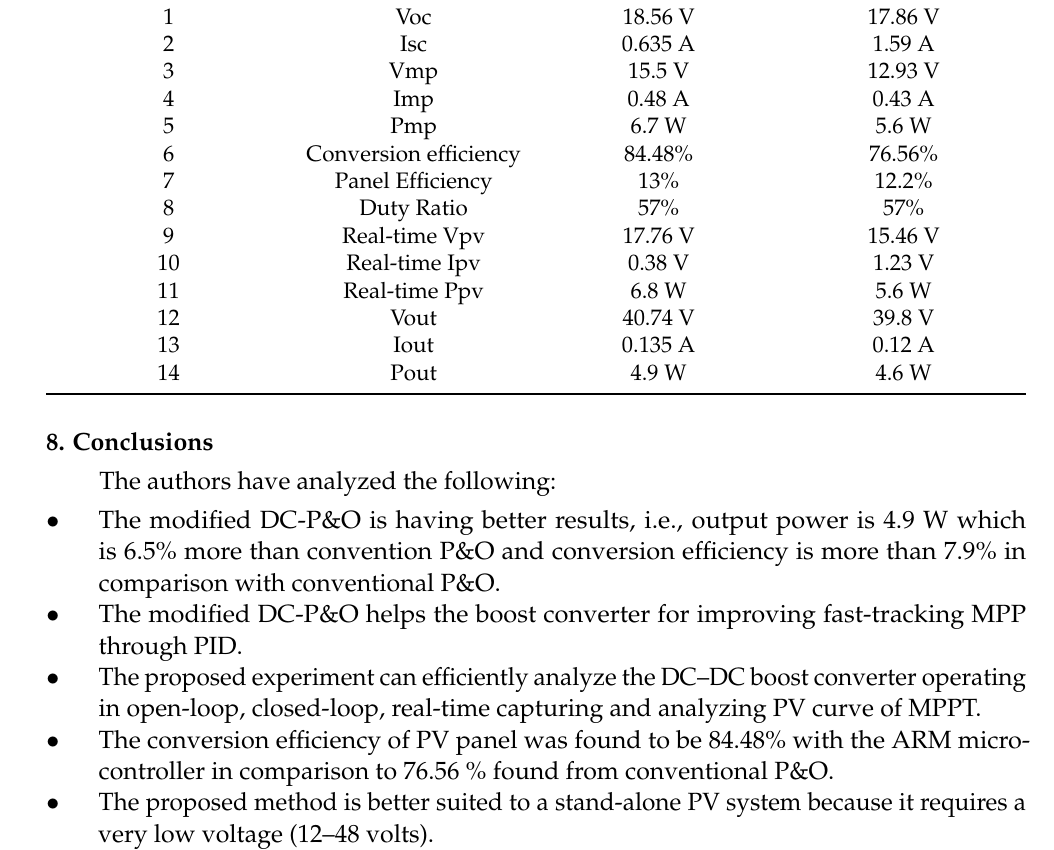
Table 5. Compared hardware results of modified (DC-P&O) technique with conventional P&O. Name of the Modified S.No Parameter